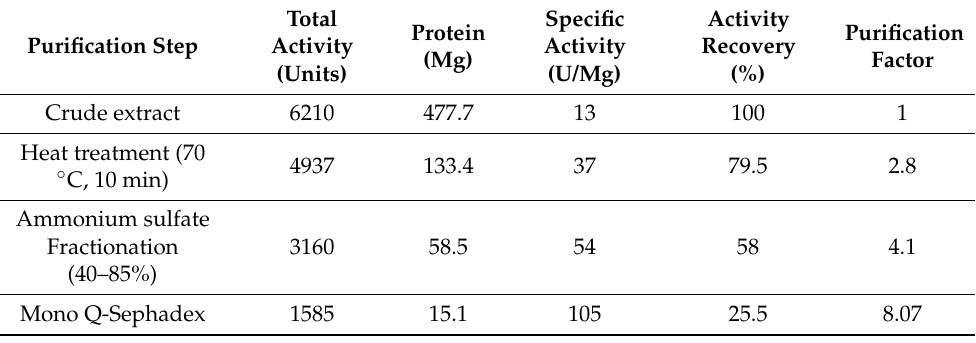
Figure 4. Purification of amB.p ( A ) ion exchange chromatography on Mono Q Sepaharose. Column of Mono Q (20 cm × 2.5 cm) was equilibrated with 0.1 M Tris-HCl buffer, pH 8. Non-adsorbed proteins were removed by rinsing the column within the same buffer. The bound proteins were then eluted into four separate peaks with a linear gradient of NaCl (0.15 to 0.5 M) at a flow rate of 30 mL/h, and 2.0 mL fractions were collected. ( B ) SDS-PAGE for Bacillus pacificus α -amylase. 1: Molecular markers (14kD, 20kD, 30kD, 43kD, 67kD, and 97Kd. 2: Mono Q Sepaharose amB.p. Table 1. Flow sheet of amBp. purification.